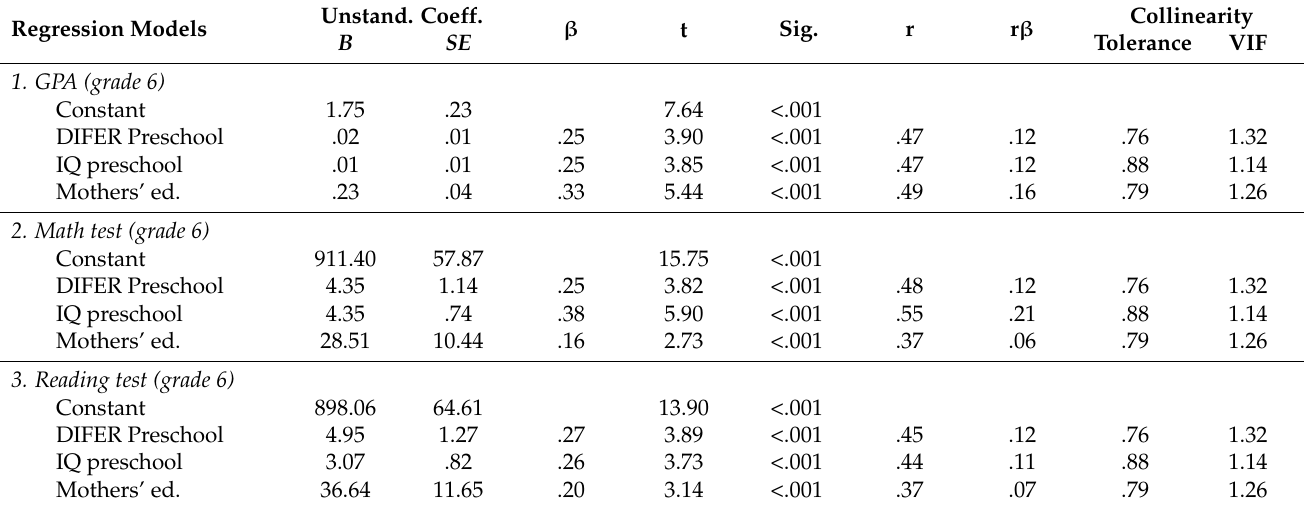
Table 5. Linear Regression